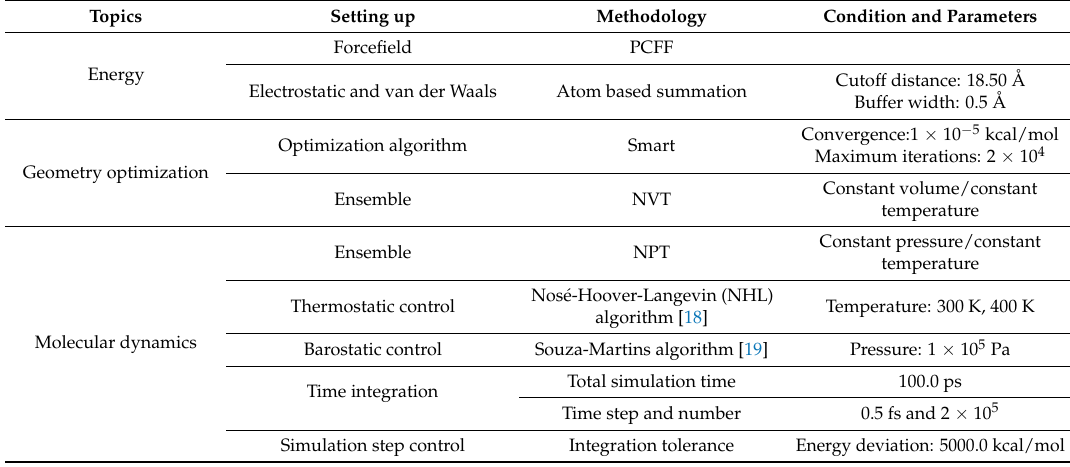
Methodology and parameters employed in geometry optimization and molecular dynamics